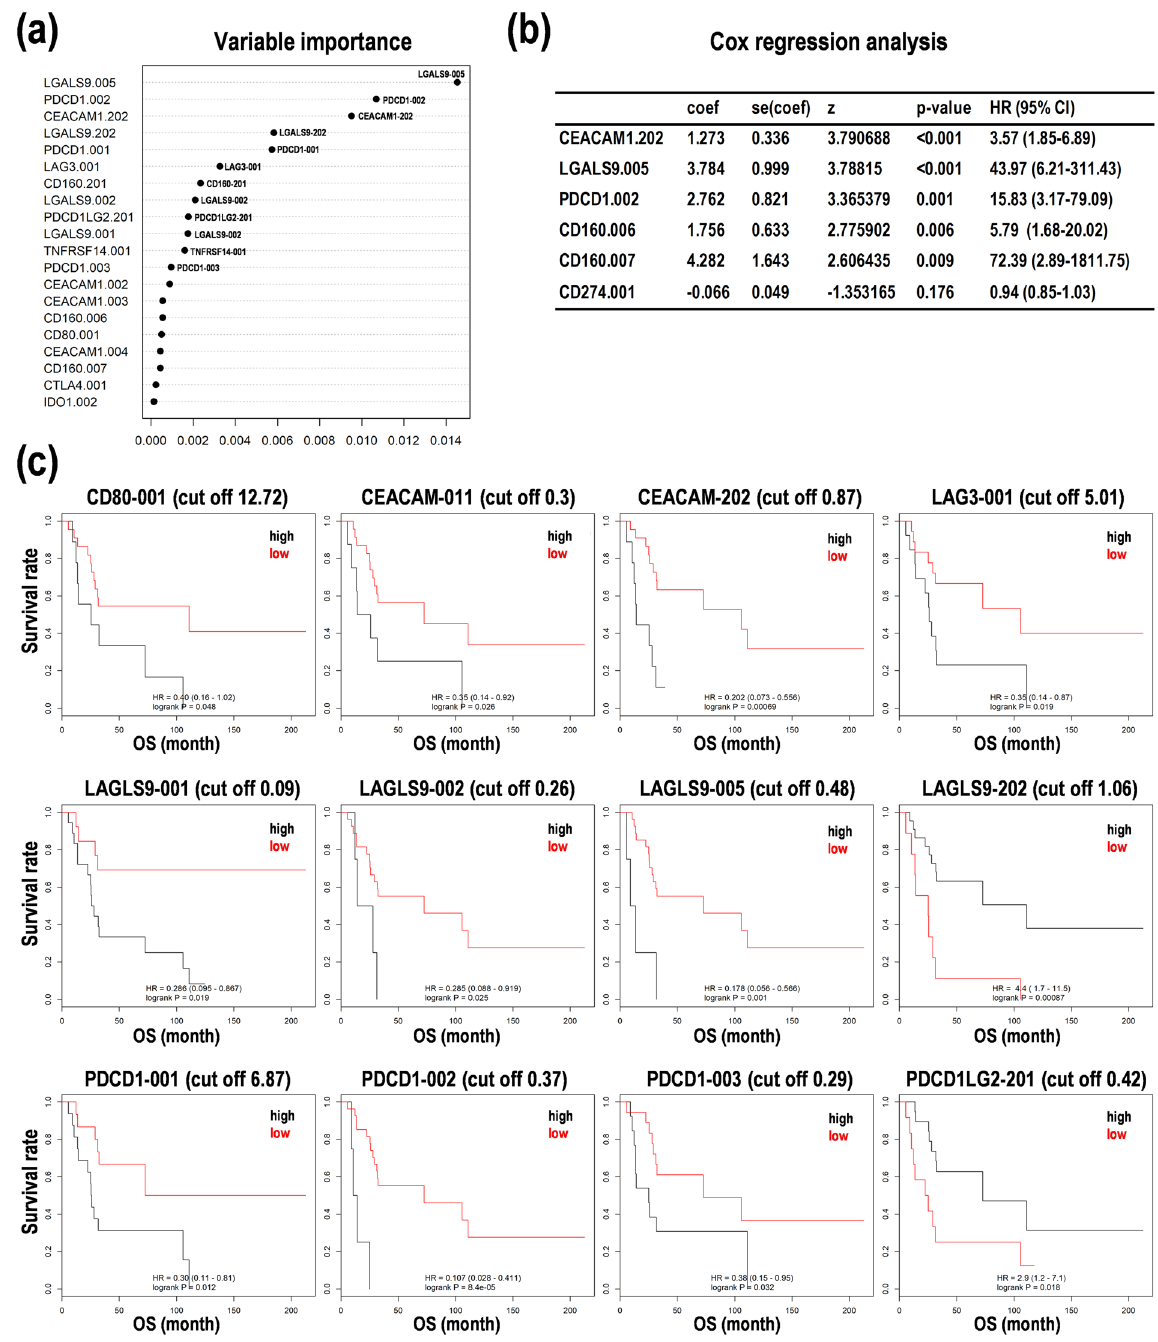
Figure 5. Random forests survival analysis and Cox regression analysis to predict prognoses with the expression of inhibitory checkpoint genes in primary central nervous system lymphoma (PCNSL). ( a ) Variable importance derived from a random forests survival analysis. ( b ) Cox regression analysis for representative genes including programmed cell death 1 (PDCD1), CD274 (PD-L1), CD160, LGALS9, and CEACAM1. Akaike information criterion (AIC)-based optimization was performed, and hazard ratios with 95% confidence interval (CI) were shown. ( c ) Kaplan-Meier analysis on the expression levels of representative genes for inhibitory checkpoint. The patients were divided into the two subgroups with high (black line) and low (red line) expression by the cutoff score of the expression of the transcript variants, including programmed cell death 1 (PDCD1), programmed cell death ligand 2 (PDCD1LG2) ( = PD-L2), CD80, LAG3, LGALS9, and CEACAM. Hazard ratio (HR) with 95% and p-value from log rank test were calculated. OS; overall